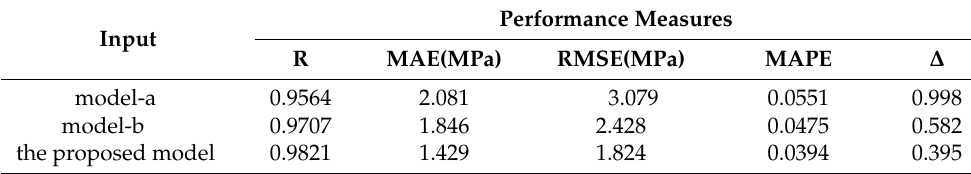
Figure 8. Comparison between the recorded actual concrete CS and the predicted value on the training set ( a ) and testing set ( b ) from the proposed GA-RF modeling. Table 5. Predictive performance comparison of the three obtained